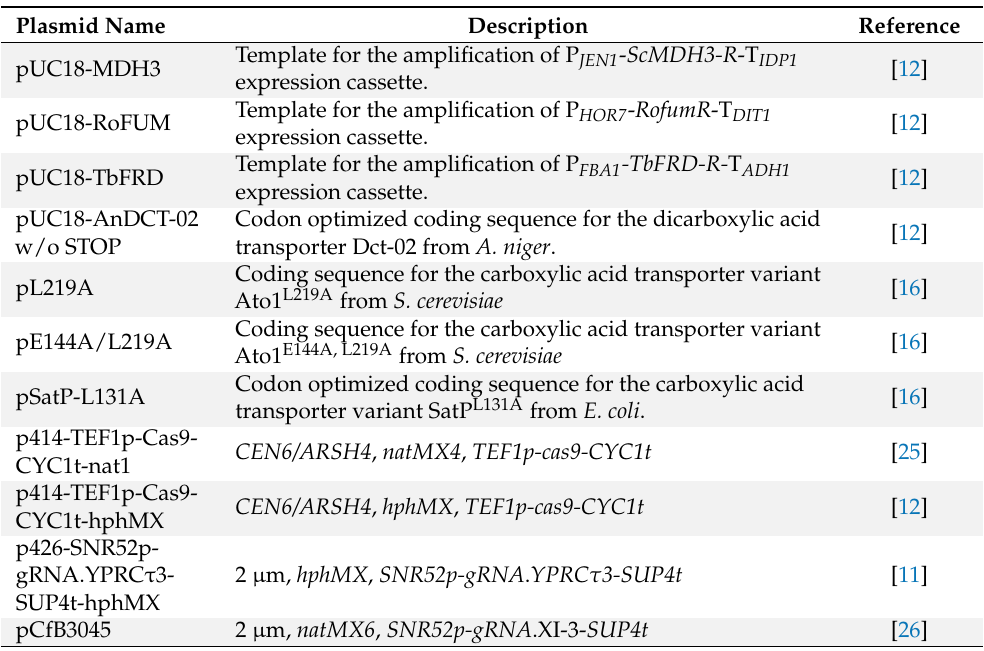
Table 2. Plasmids used in this